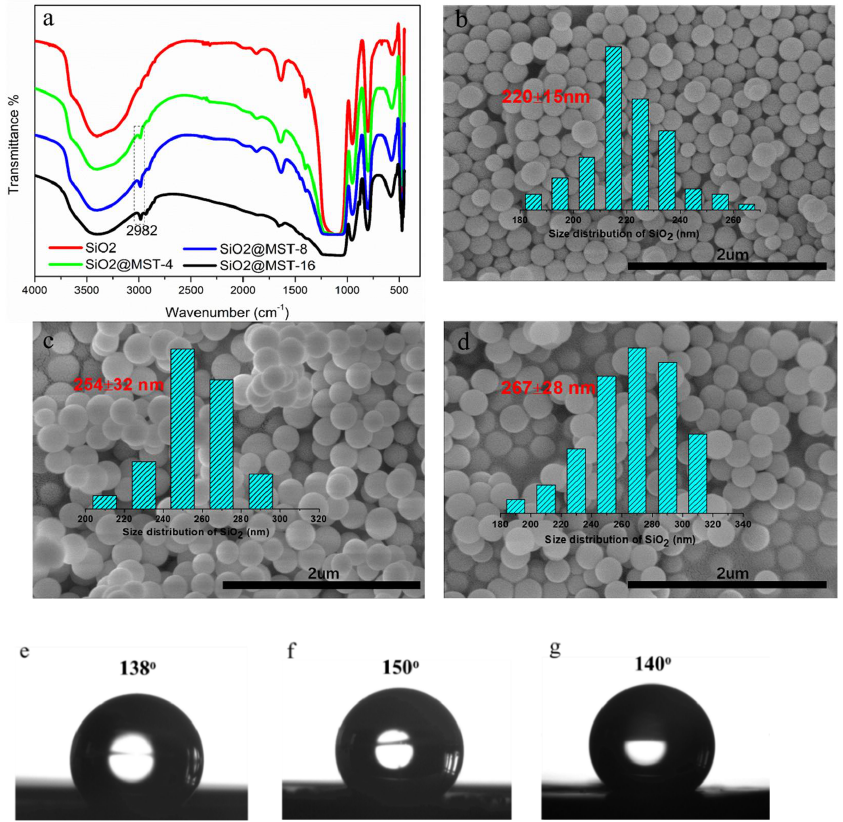
Figure 4. ( a ) FT-IR spectra of SiO 2 and surface-modified SiO 2 , ( b – d ) SEM images of different sur- face-modified SiO 2 , and ( e – g ) contact angles of different surface-modified SiO 2